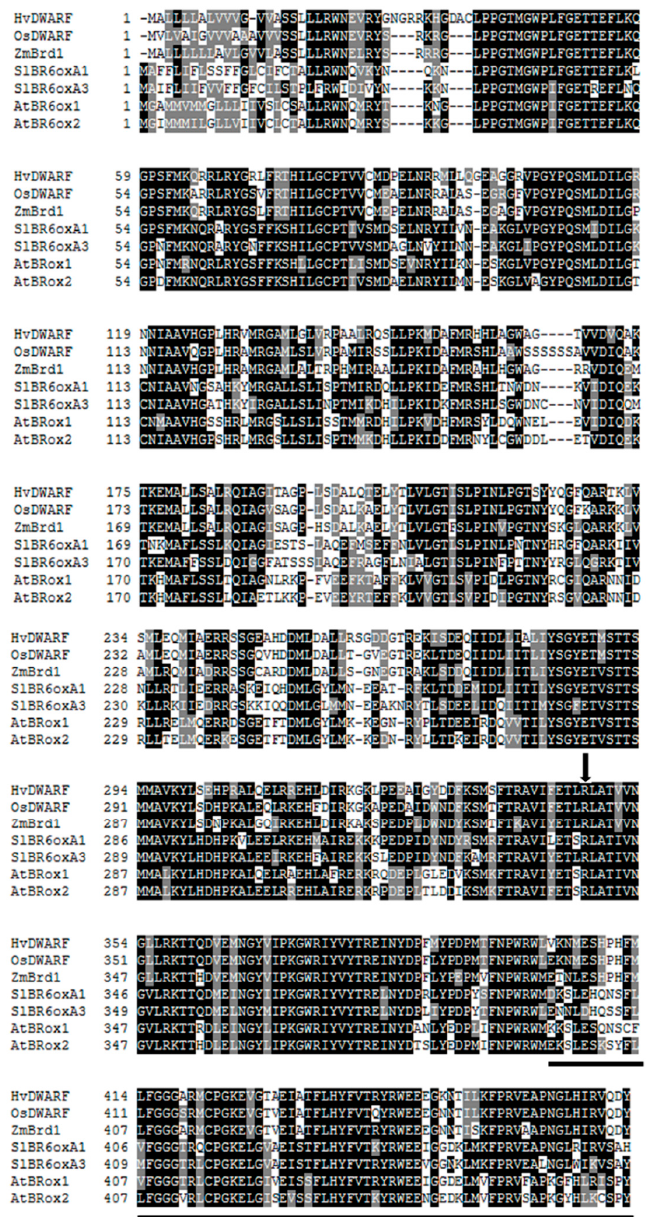
Figure 2. Alignment of the homologous proteins from Hordeum vulgare (HvDWARF, GenBank: AEG64639), Oryza sativa (OsDWARF, GenBank: AAT81671), Zea mays (ZmBrd1, GenBank: ACG46988), Solanum lycopersicum (SlBR6oxA1, GenBank: AAB17070 and SlBR6oxA3, GenBank: NP_001234520) and Arabidopsis thaliana (AtBR6ox1, GenBank: BAB60858 and AtBR6ox2, GenBank: NP_566852), performed with ClustalW and visualized in BOXSHADE. In case of A. thaliana and S. lycopersicum paralogous sequences were included. Highly conserved Arg-347, which is substituted by the mutation identified in the brd1-c allele, is indicated by the arrow, protein fragment whose sequence was altered as a result of the mutation in the brd1-d allele is underlined. In the barley HvDWARF protein the P450 cytochrome domain encompasses protein region 21–472. Black shade—fully conserved residue, grey shade—partially conserved residue.